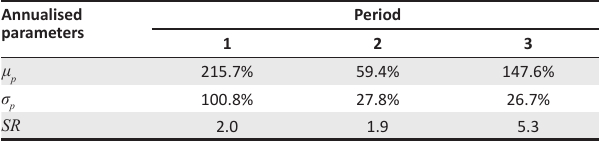
TABLE 3: Summary of the performance of the portfolio C tangent portfolios during periods 1, 2 and 3. Annualised parameters